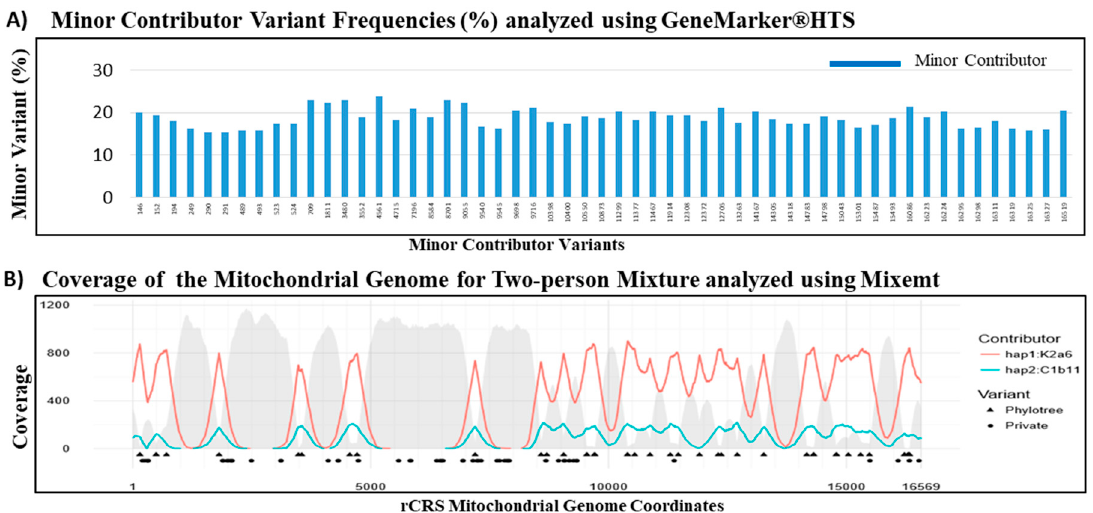
Figure 6. De-convolution of mtDNA mixtures using GeneMarker ® HTS and Mixemt Software. ( A ) The variant frequency based software GeneMarker ® HTS successfully separated all minor contributor variants from the 80:20 two-person mixture. ( B ) The phylogenetic based software Mixemt also successfully assigned the sequence reads to major and minor contributors based on the phylogenetic variants (triangles). Red line represents the depth of coverage for reads containing phylogenetic informative variants of haplogroup K2a6, teal line represents the depth of coverage for reads containing phylogenetic informative variants of haplogroup C1b11, and gray areas indicate depth of coverage for the reads that were unassigned. Private mutations (circles) did not affect Mixemt in assigning sequence reads to their respective contributors.